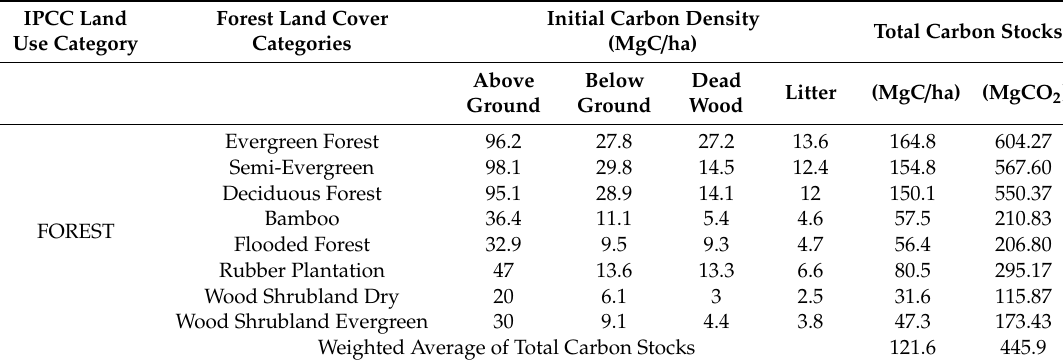
Table 3. Selected forest land use categories and initial carbon density for Siem Reap province.